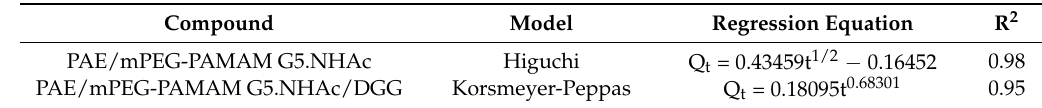
Table 6. Release mechanism of